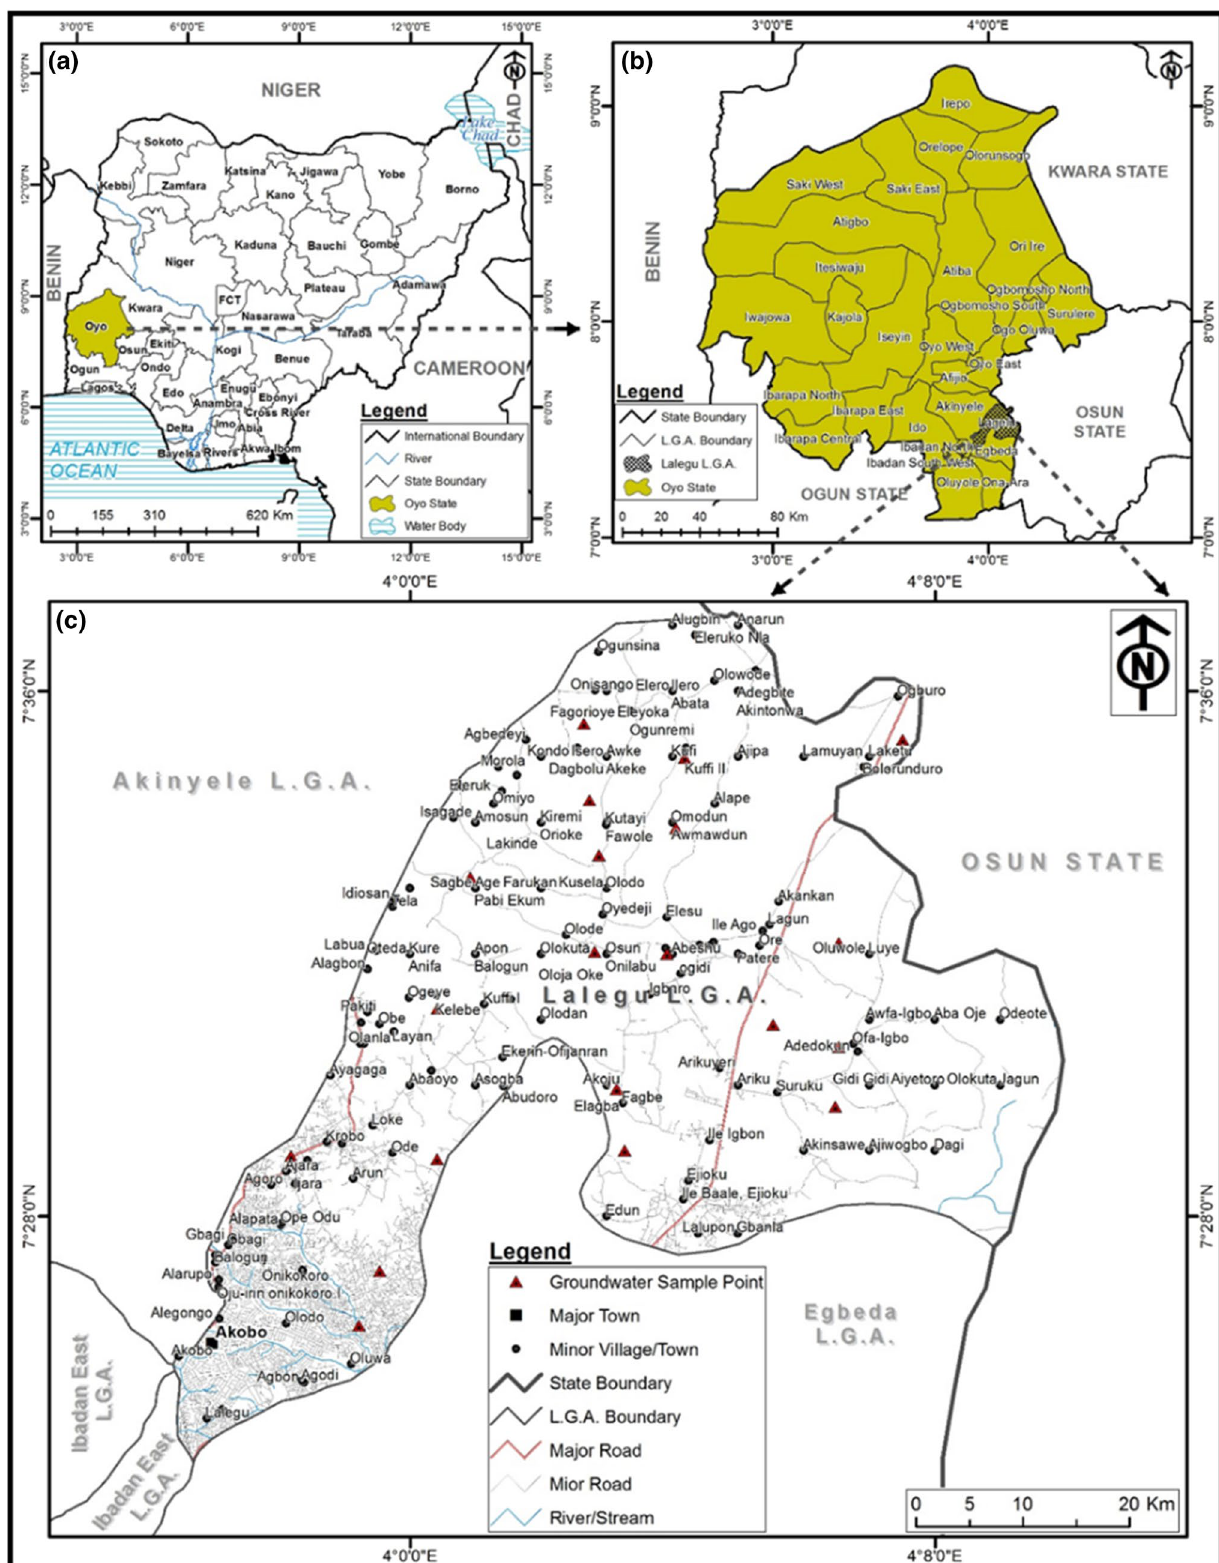
Fig. 1 Map of a Nigeria showing Oyo State, b Oyo State showing Lagelu and c Lagelu showing the groundwater sample